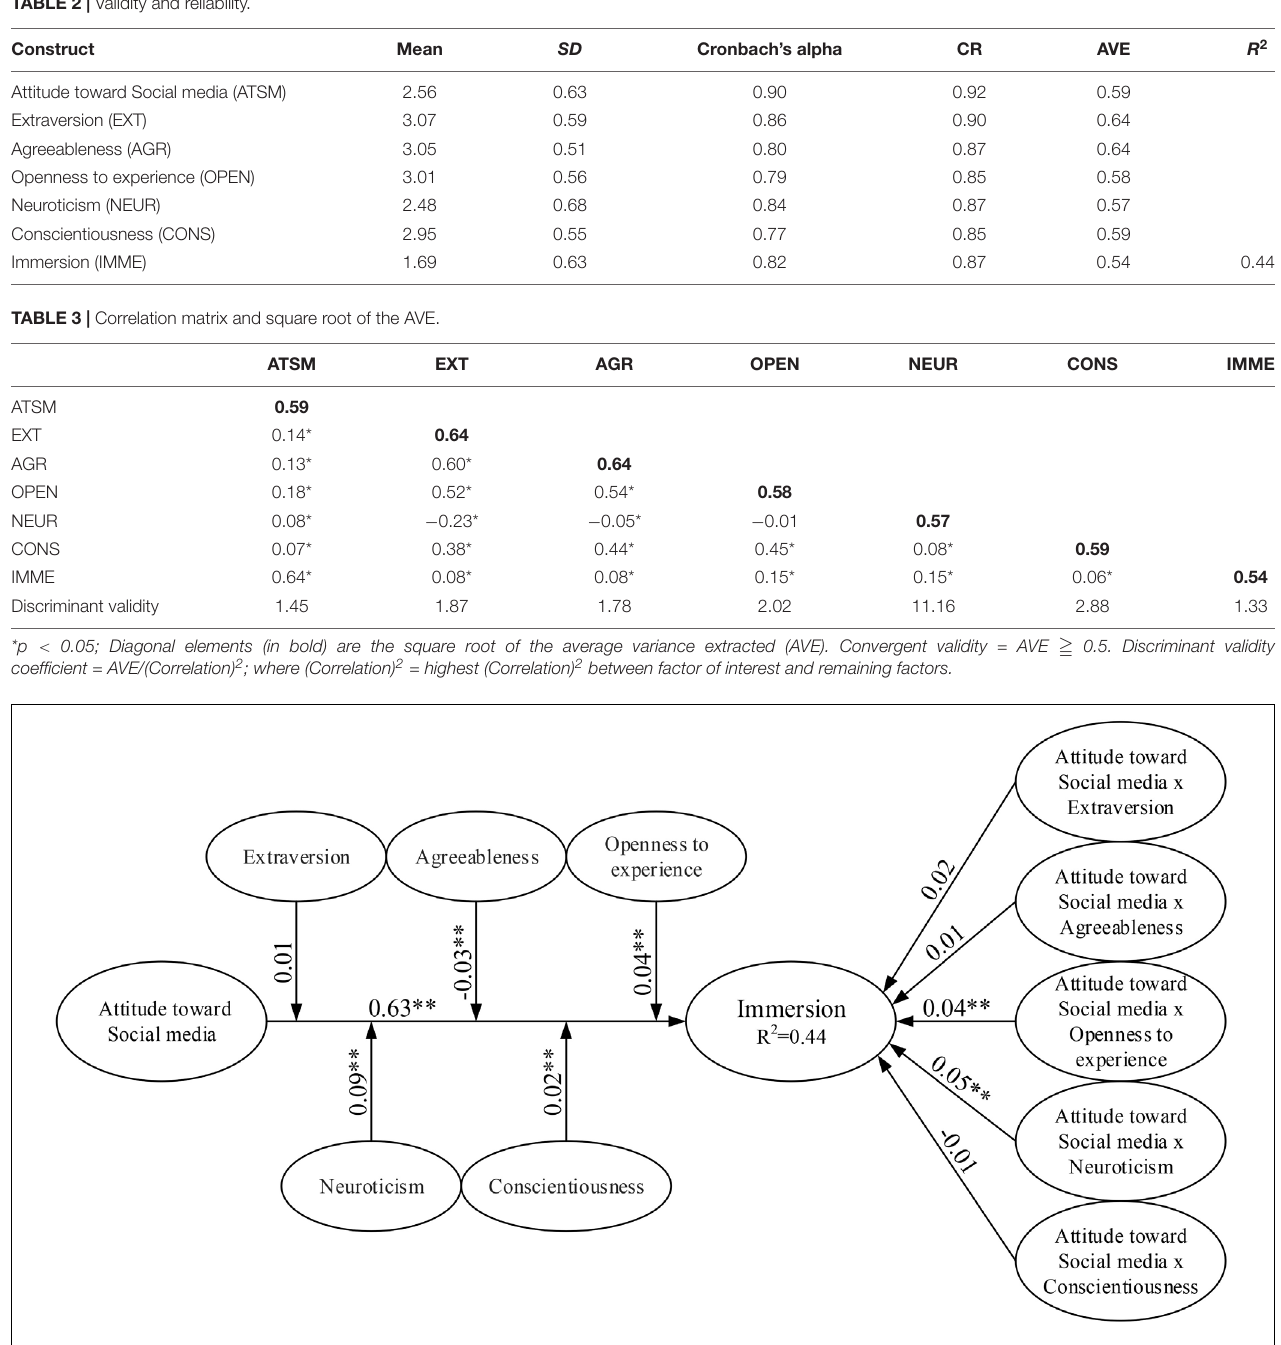
FIGURE 2 | Results of the structural model testing. Value on path: standardized coefficients ( β ); R 2 : coefficient of determination; and ∗ p < 0.1, ∗∗ p <